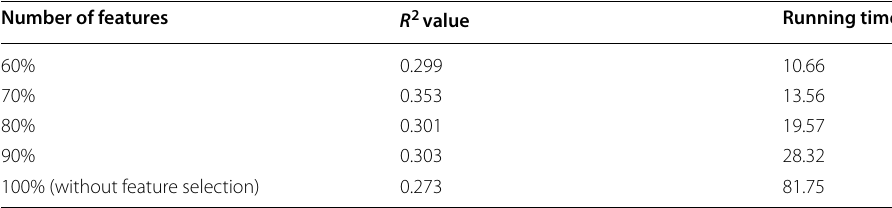
Table 9 QSAR-RFR(SPCA) simulation results on FCFP_6 dataset Number of features